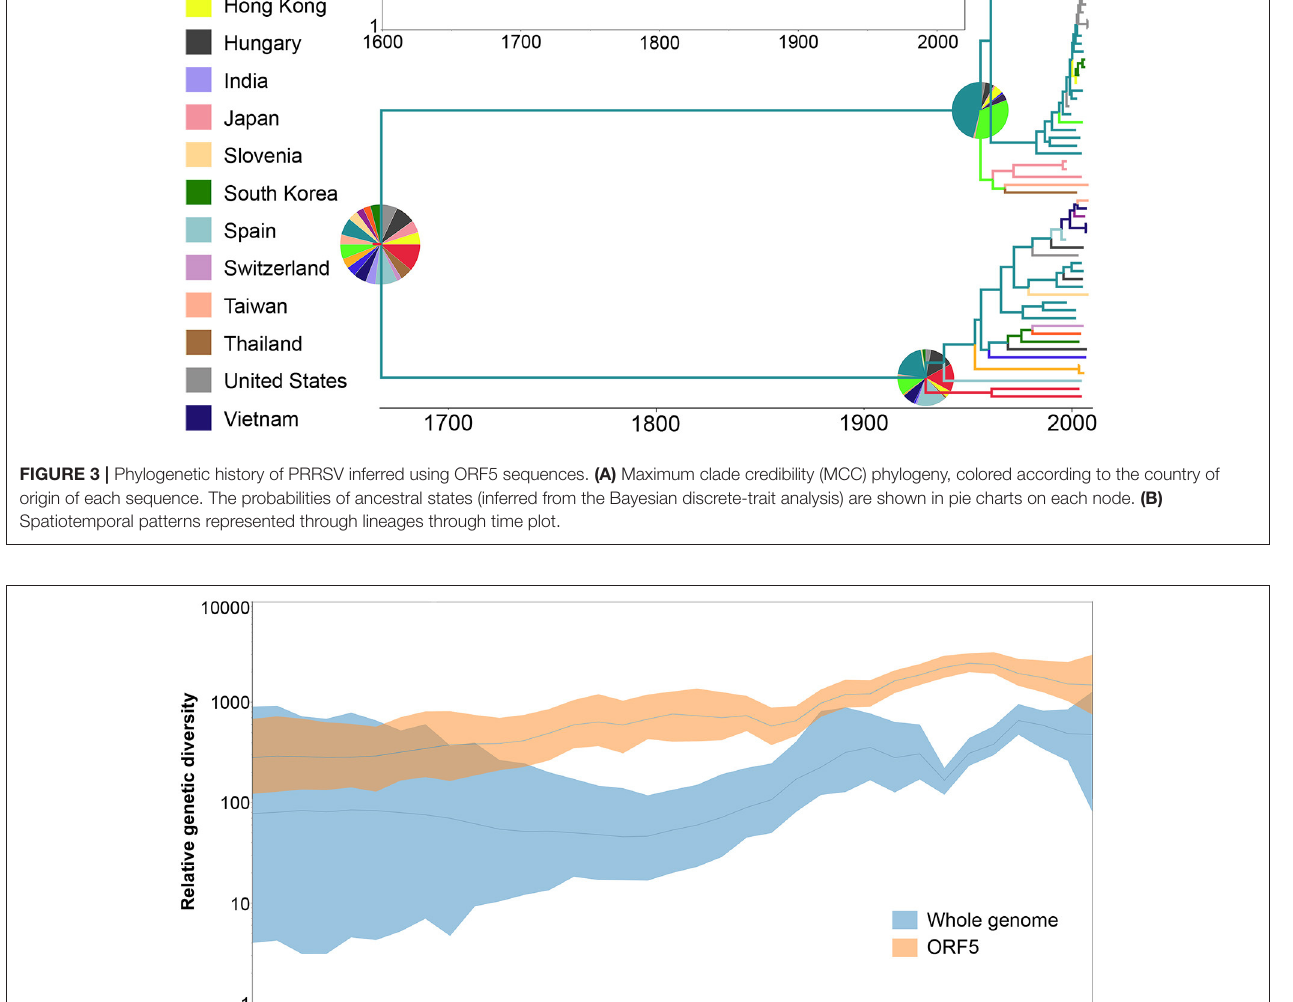
a deviation on research efforts toward that disease. This